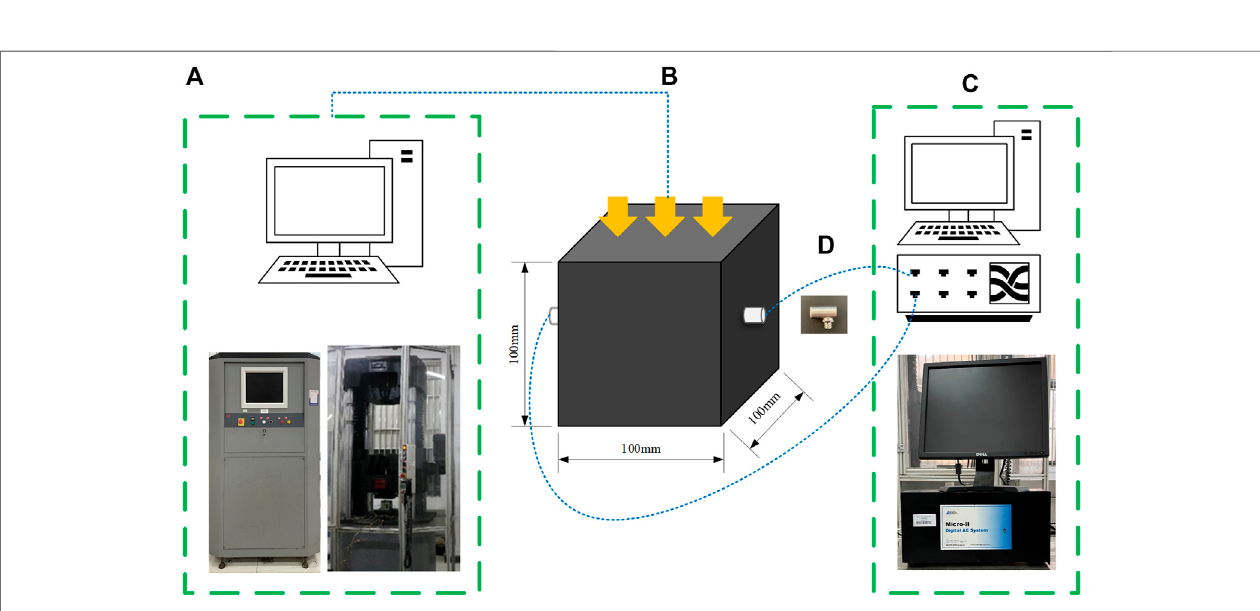
Figure 2C . The acoustic emission preampli fi er can provide gains of 20 dB, 40 dB, and 60 dB in three different gears. The type of acoustic emission probe used is Beijing Soft Lead RS-54A, with a diameter of 8 mm and a monitoring frequency range of 100 – 900 kHz, as shown in Figure 2D . In order to ensure the